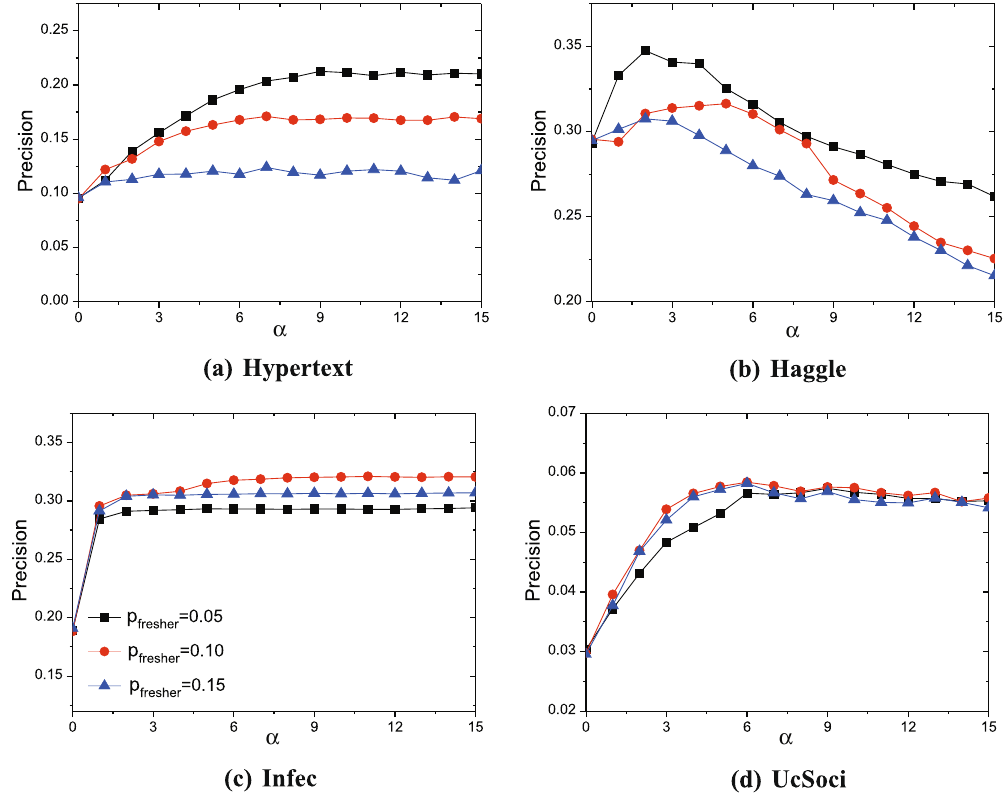
Figure 2. Precision versus α obtained by PBSPM. The experiments are performed on 90% training set and 10% probe set. Each data point is averaged over 10 independent realizations. The values of p fresher and α corresponding to the optimal precision reported in Table 1 vary for different networks: 0.05 and 9 for Hypertext, 0.05 and 2 for Haggle, 0.10 and 11 for Infec, 0.10 and 7 for UcSoci.